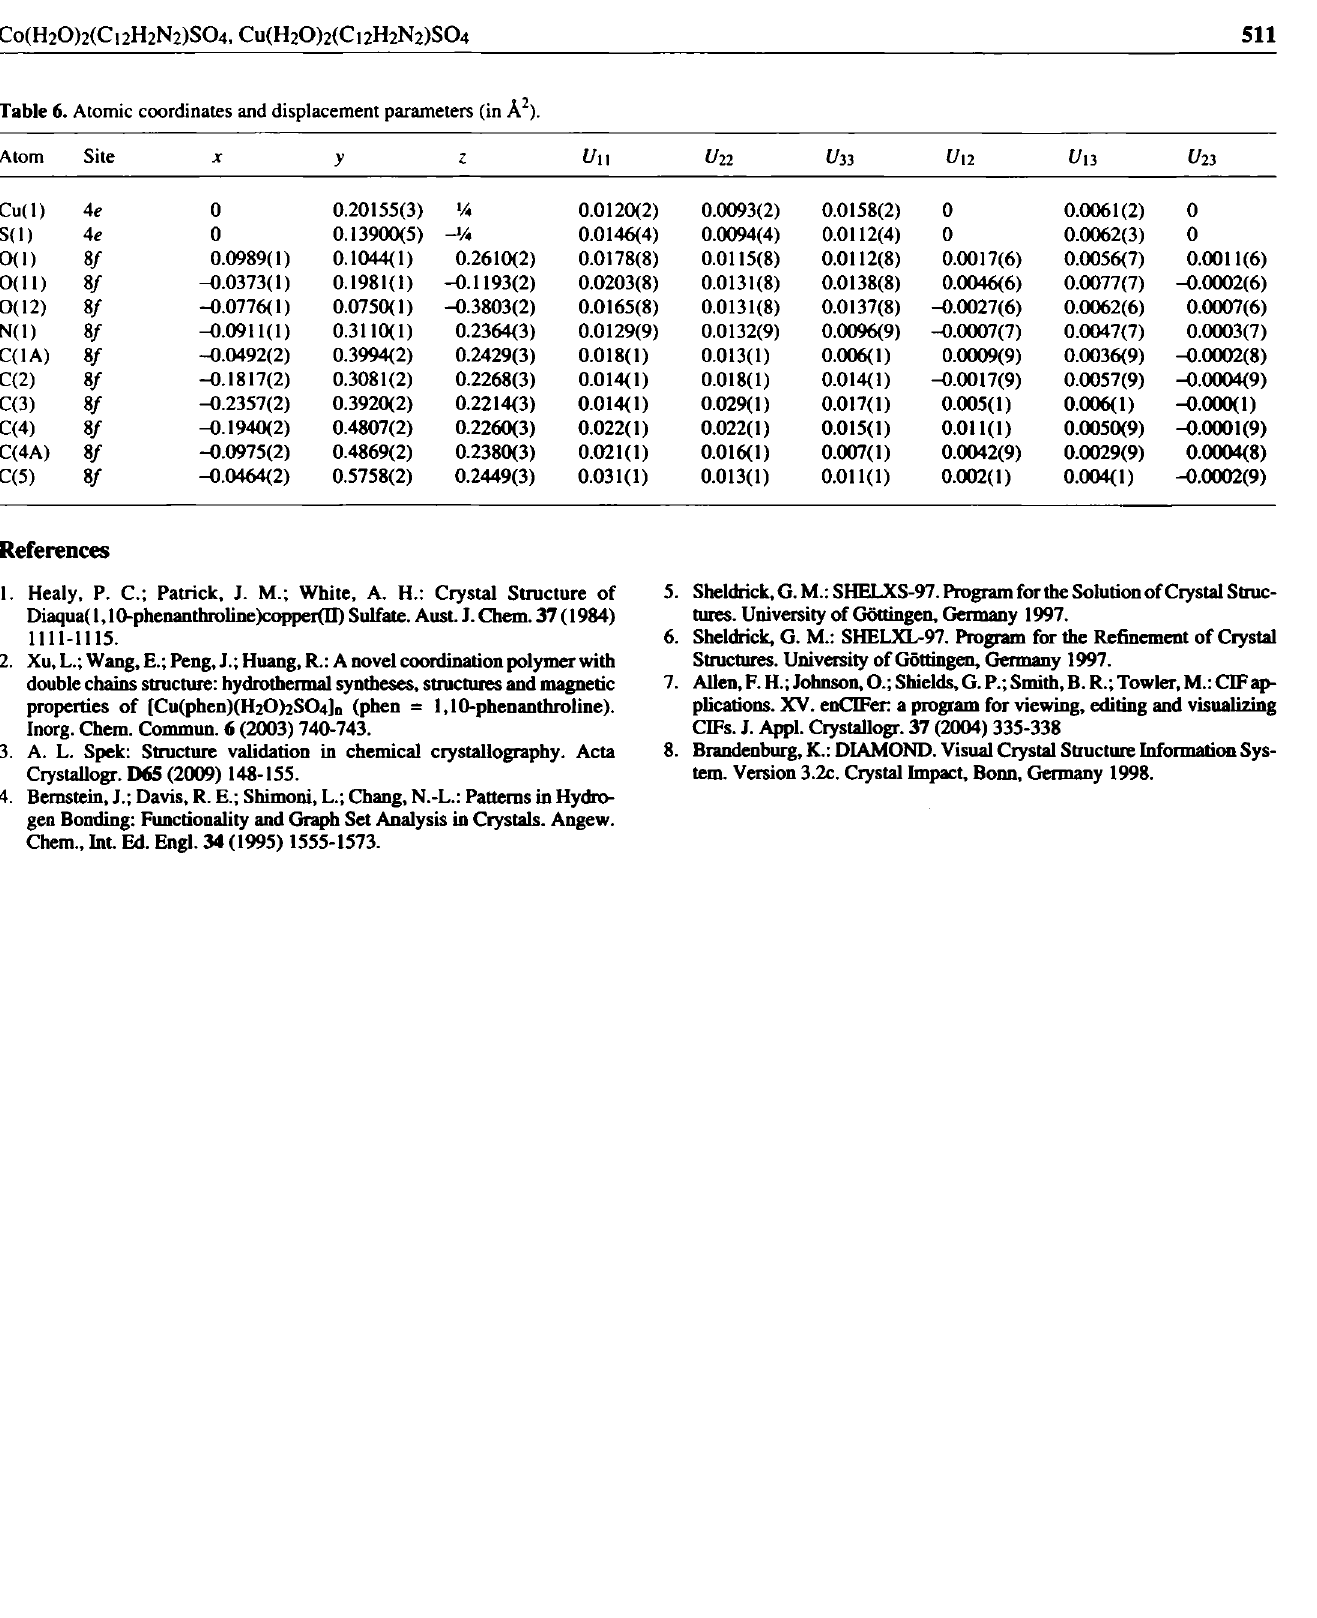
Table 6. Atomic coordinates and displacement parameters (in Â 2